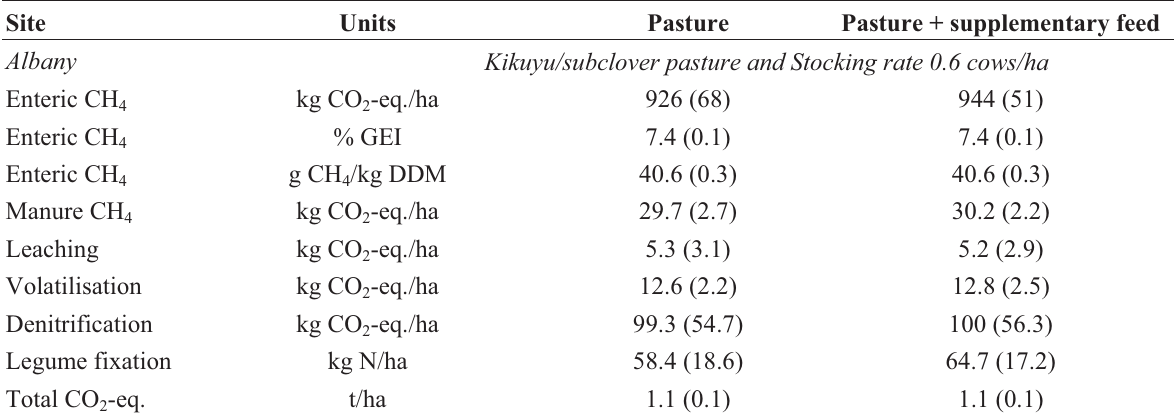
-eq.) equivalent emissions per 2